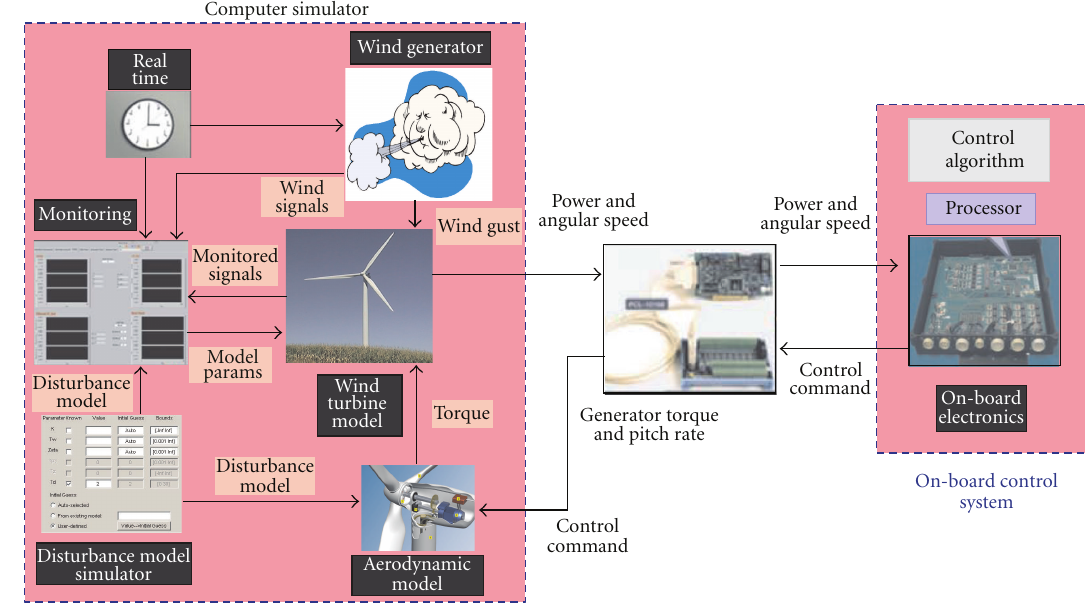
Figure 7: Main elements of the HIL